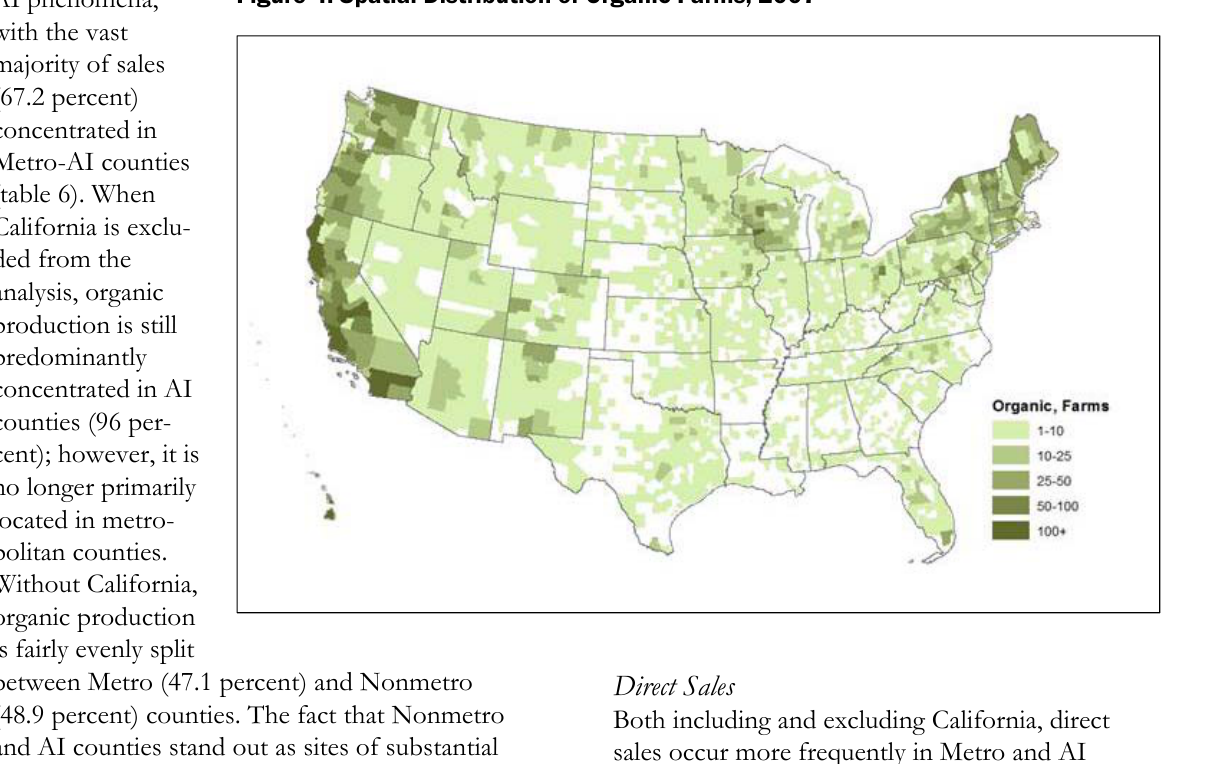
Figure 4. Spatial Distribution of Organic Farms,